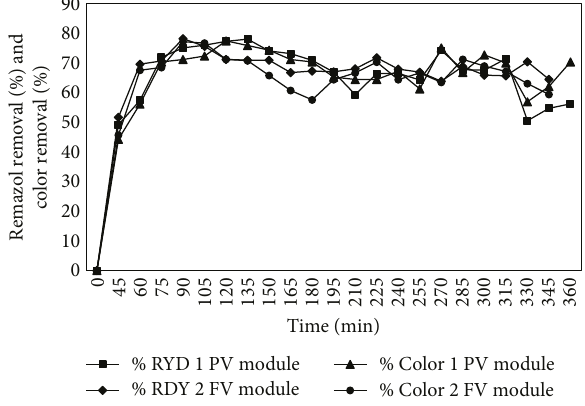
Figure 5: Remazol removal and color removal under continuous fl ow with the application of photovoltaic modules: liquid fl ow rate: 300 mL · min − 1 ; initial concentration of RYD: 100 mg · L − 1 . % RYD one PV module, % RYD one PV module, color one PV module, and color two PV